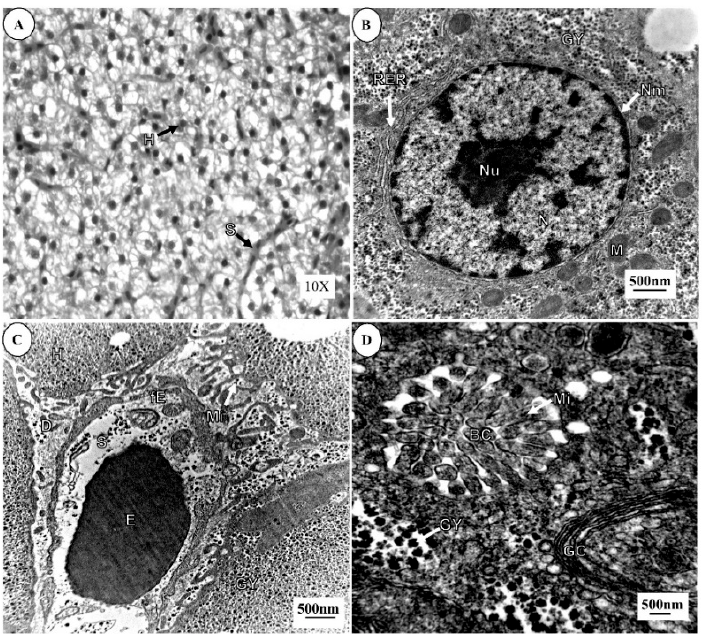
Figure 1. Hepato-architecture of control C. carpio . ( A ) (10 × ): Liver with sinusoid (S). ( B ): Hepatocyte (H) showing central nucleolus (Nu), spherical nucleus (N) enclosed in nuclear membrane (Nm) and extended into RER, spherical to oval mitochondria (M) and abundant glycogen (GY) molecules. ( C ): Space of Disse (D) present between hepatocytes (H) and sinusoid (S), bearing erythrocyte (E) enclosed within fenestrated endothelium (fE). Microvilli (Mi) radiate in the space between. ( D ): Bile canaliculi (BC) with irradiating microvilli (Mi) and cisterns of Golgi complex (GC).